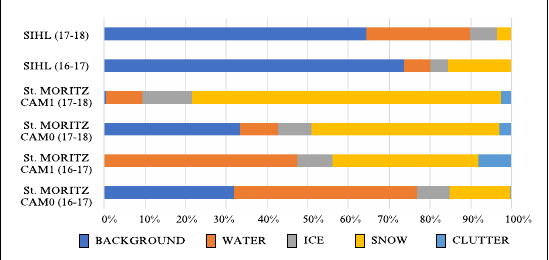
Figure 6: Class imbalance (ground-truth) in the Photi-LakeIce dataset. Best if viewed on-screen. resized to a spatial resolution of 512 × 512 for further use. Ex- amples are shown in Figs. 13a and